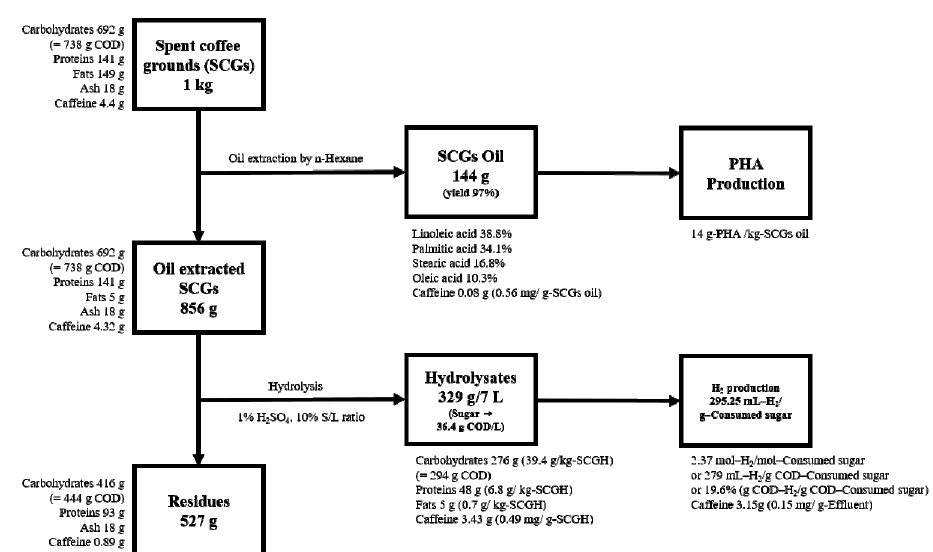
Figure 7. Mass balance of coffee grounds to bio-hydrogen and PHA.